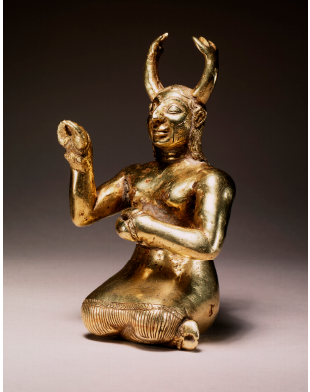
Figure 1. Elamite anthropomorphic bull deity seated cross-legged (c. 3rd millennium BCE), © Miho Museum. This figurine is visually comparable with the Paśupati seal. Given the intense exchanges between the Mesopotamian civilization and that of the Indus Valley, it is possible to assume a con- nection with the next seal. Courtesy of the Miho Museum.